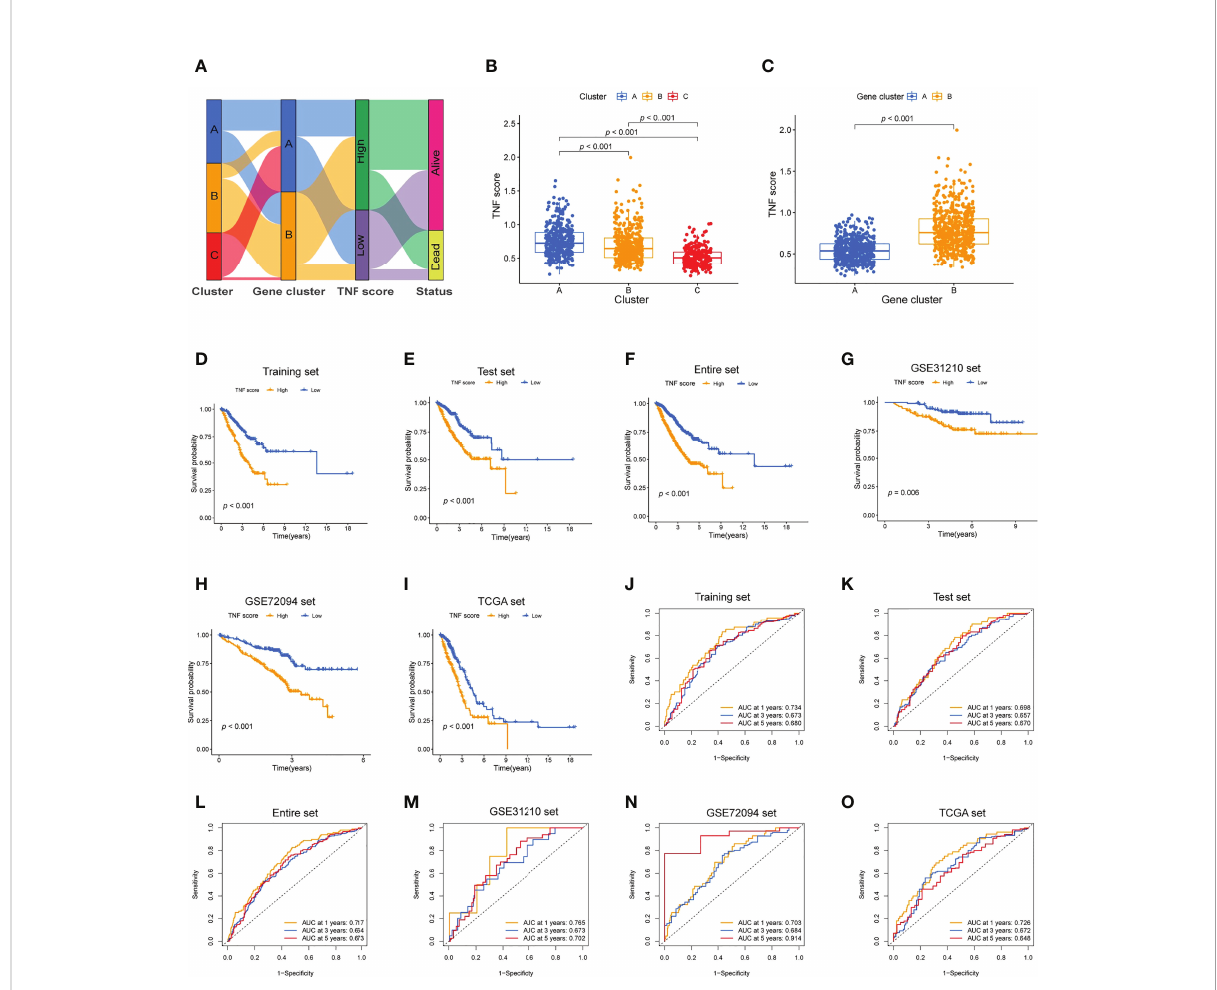
FIGURE 4 Development of the TNF scoring system and its clinical consequences. (A) Alluvial diagram describing the relationship of the TNF cluster, TNF gene cluster, TNF score, and survival outcome group. (B) Boxplot of the TNF scores among the three clusters. (C) Boxplot of the TNF scores between the two gene clusters. (D – I) Survival analysis of the patients with high and low TNF scores in the different LUAD cohorts. (D) Training set, p < 0.001; (E) Testing set, p < 0.001; (F) Entire set, p < 0.001; (G) GSE31210 set, p = 0.006; (H) GSE72094 set, p <.001; (I) TCGA set, p < 0.001. (J – O) Time-independent ROC analysis of the risk scores for predicting the